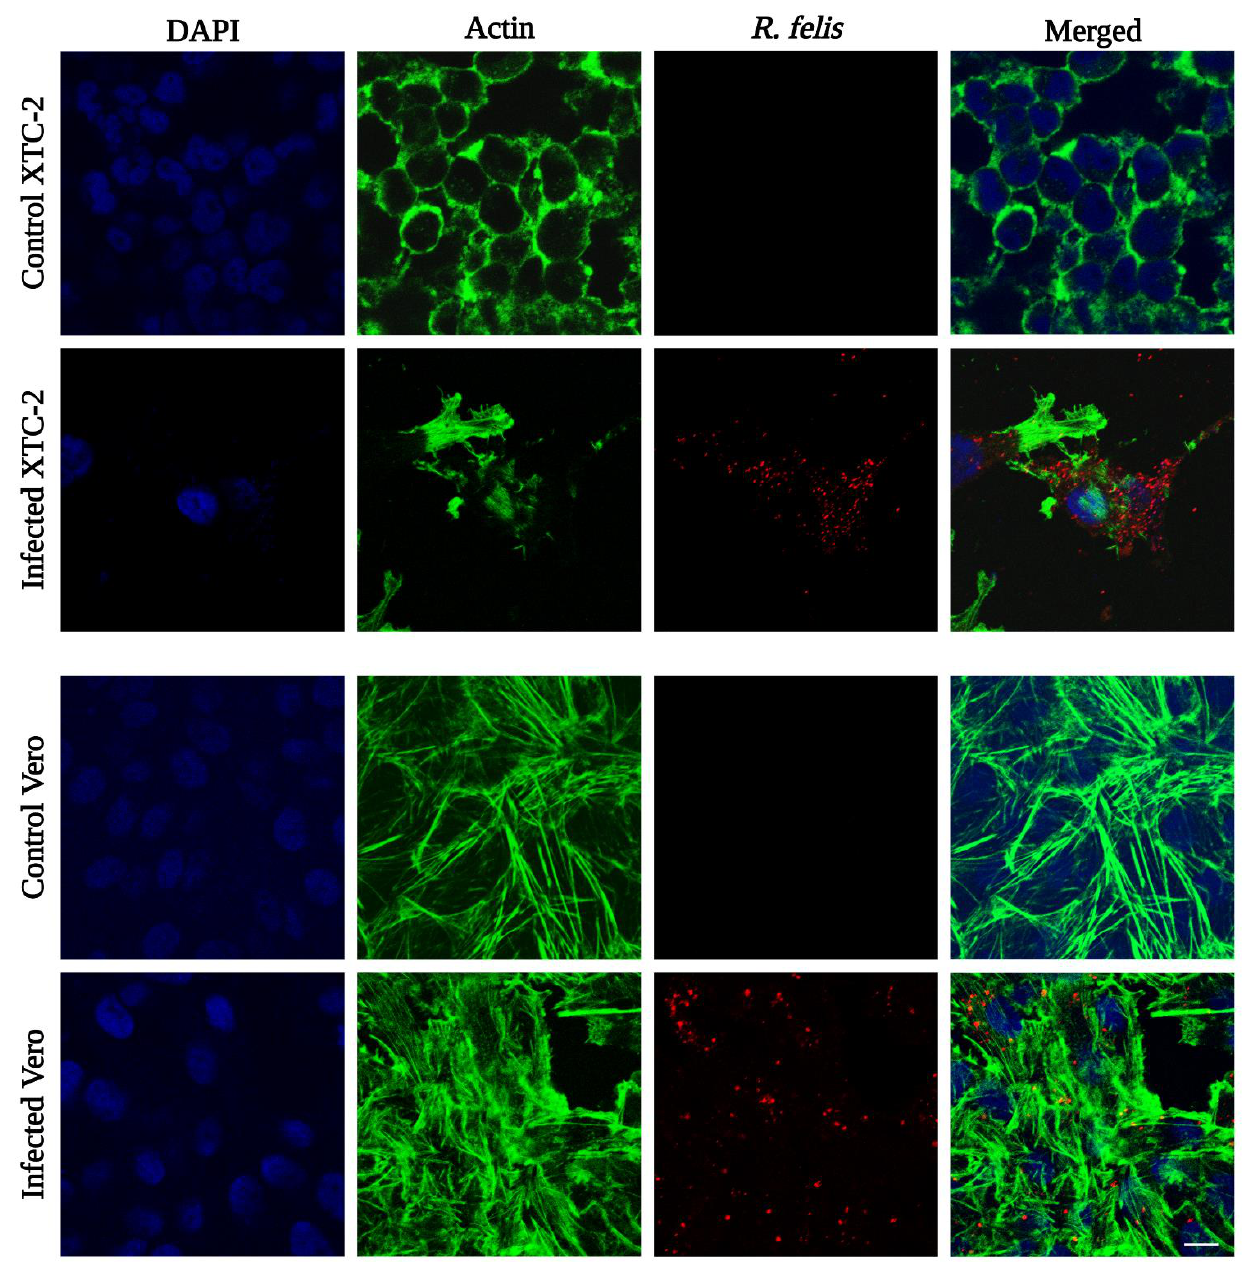
Figure 6. Detection of R. felis Danube by immunofluorescence assay. Infected XTC-2 and Vero cells were fixed with 4% paraformaldehyde in PHEM buffer, and rickettsiae were labeled with rabbit polyclonal antibody against R. conorii , followed by rhodamine-conjugated goat anti-rabbit antibody (red signal). Actin filaments of host cells were labeled with conjugated phalloidin (green signal), and cell nuclei were stained with DAPI (blue signal). Uninfected cells treated with both primary and secondary antibodies were used as negative controls (scale bar 10 µm).